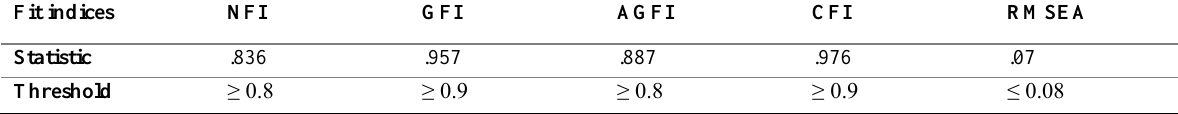
Table 6: Fit indices of the structural model connecting TI and performance